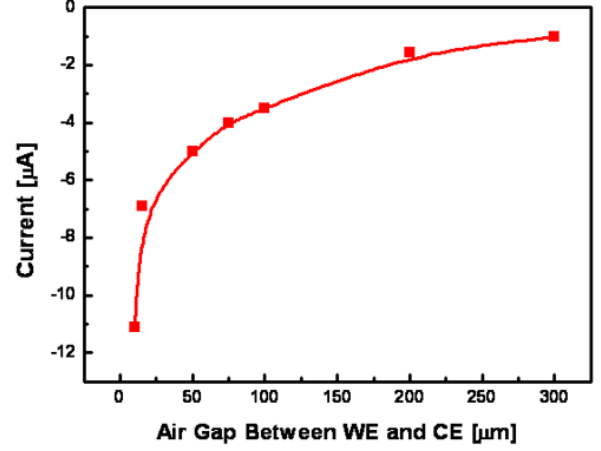
Figure 8. Current responses of non-enzymatic glucose micro-sensors with different air gaps between WE and CE in 5 mmolL -1 glucose concentrations (Air gap from 10 to 300 µ m).